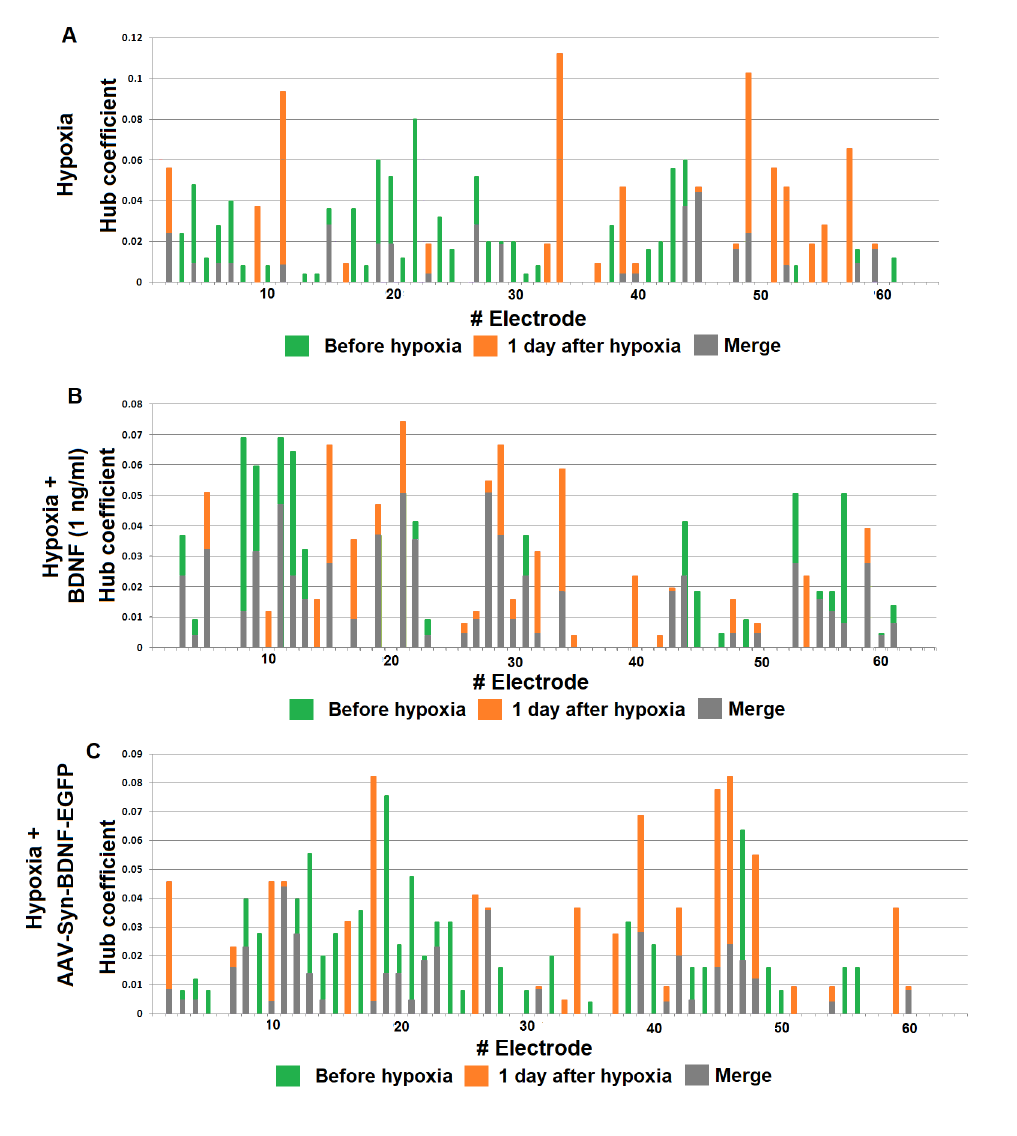
Figure 8. Functional rearrangement alterations of neural networks in the posthypoxic period. The hub coefficient was calculated as the ratio of the number of connections of an electrode to its total number in the graph, and thus characterizes the importance of a group of neurons located at one electrode for network activity. Plotting the hub coefficient allows estimation of the changes in the significance of each electrode in a multi-electrode array. ( A ) Hypoxia; ( B ) hypoxia + BDNF 1 ng/mL ( C ) hypoxia + AAV-Syn-BDNF-EGFP. The data show changes in the significance of individual electrodes in the “hypoxia” group on day 1 of the posthypoxic period ( A ), whereas the hypoxia + BDNF and hypoxia + AAV-Syn-BDNF-EGFP groups ( B , C ) had a preserved number of main hubs in the network, although some displacement of several individual electrodes was